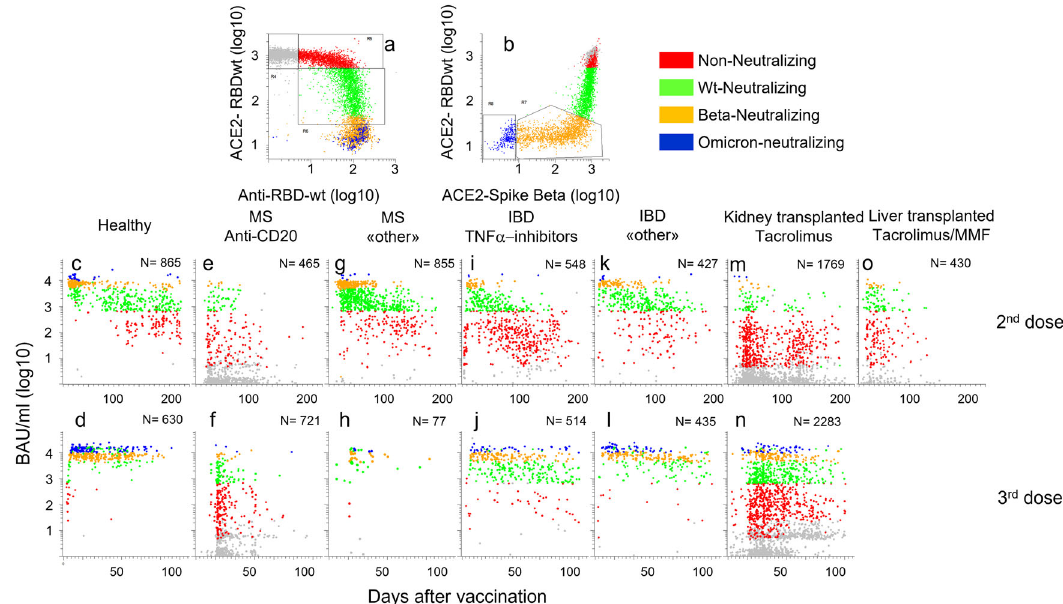
Fig. 8 Large-scale analysis of humoral responses to COVID-19 vaccination. Indicated numbers of post-vaccine sera obtained from healthy individuals and patients on immunosuppressive therapy were analyzed with Multi-IgG-ACE2-RBD. Each dot corresponds to a different sample. a , b See legend to Fig. 5a-b. c – o : The x - and y -axes show days after vaccination and antibody levels in BAU/ml (log 10), respectively. MS: multiple sclerosis, IBD: In fl ammatory bowel disease. “ Other ” : IBD: alpha 4 beta 7 antagonist, IL12_IL23 antagonist, MS: Cladribine, Le fl unomide, glatirameracetate, interferon beta, Alpha 4 beta 1 antagonist. Tacrolimus was used in combination with other agents, mainly mycophenolic acid. Source data are provided as a Source Data fi